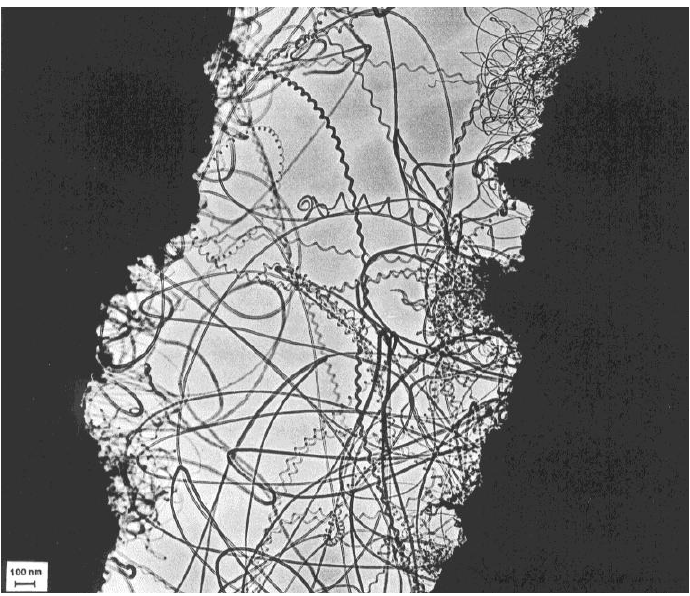
Figure 6. TEM image of helical carbon nanotubes formed in the decomposition of acetylene at 700 °C over Co/silica prepared by method A (pH = 9). Reproduced from [68] with